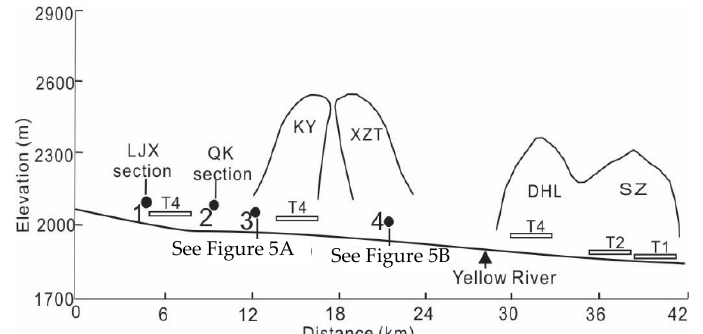
Figure 7. Longitudinal river profile showing present-day elevation, locations of landslides, terraces and lacustrine sediments. “3” denotes an outcrop where nearshore of the dammed lake overlaid the Xiazangtan landslide mass on the west bank of the Yellow River. “4” denotes folds in the lacustrine sediments at the toe of Kangyang landslide, which is inferred to reflect that the dammed lake caused by the Dehenglong–Suozi landslides was surged to the north bank of the Yellow River. T1, T2 and T4 denote the first, second and fourth terrace. The third terrace was inferred to be eroded in to and / or capped by landslide deposits and lake sediments.